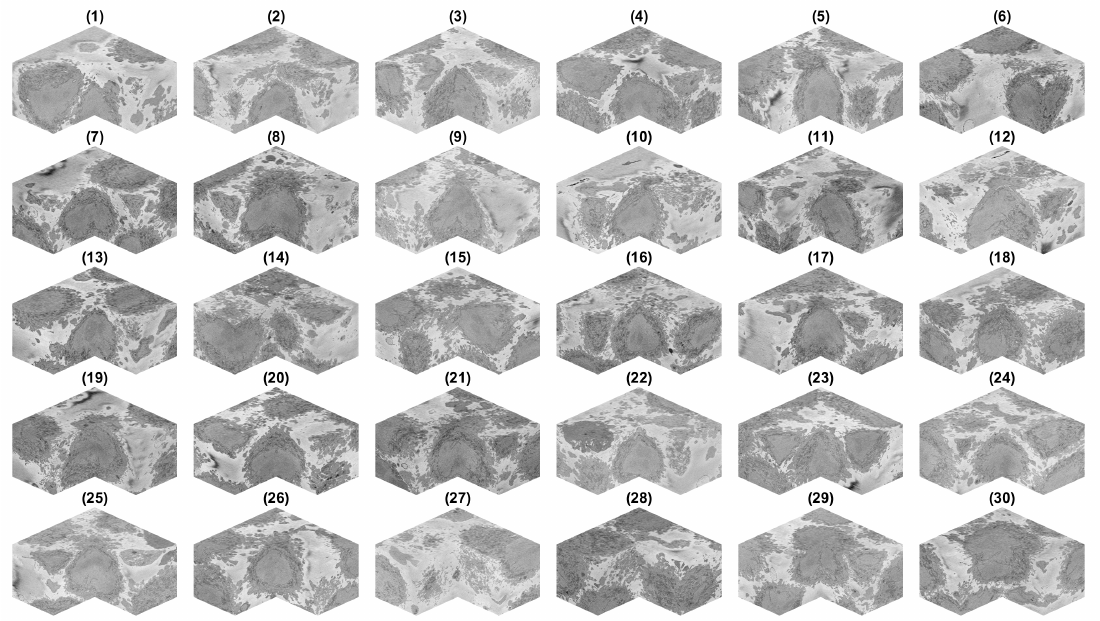
Figure 6. ROIs cropped from the volume. Thirty regions of interest were detected and cropped. For each region of interest, a corner was removed to show the cell, which should be centred. It should be noted that some cells were not in the centre, but rather positioned towards the bottom of the volume (e.g., 1), the top (e.g., 30) or the sides (e.g., 6,14,15,27,28). It was observed that some of the ROIs were close to the top or bottom (e.g., ROIs 1, 2, 29, 30) and thus would contain only part of a cell, and the rest would be outside